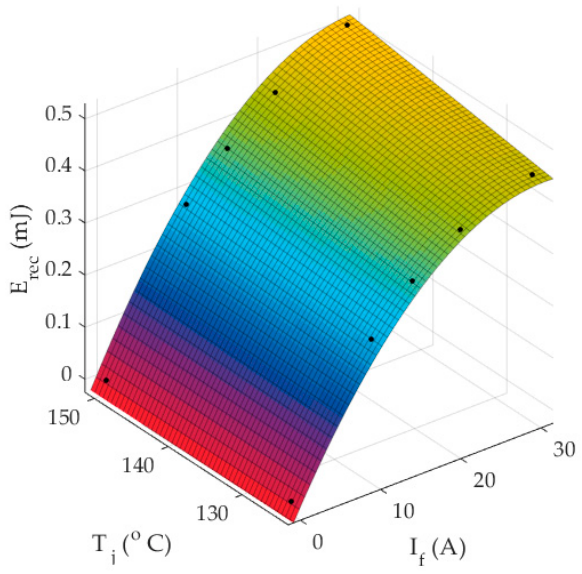
Figure 7. Interpolation of rec E for different diode currents and junction temperatures.